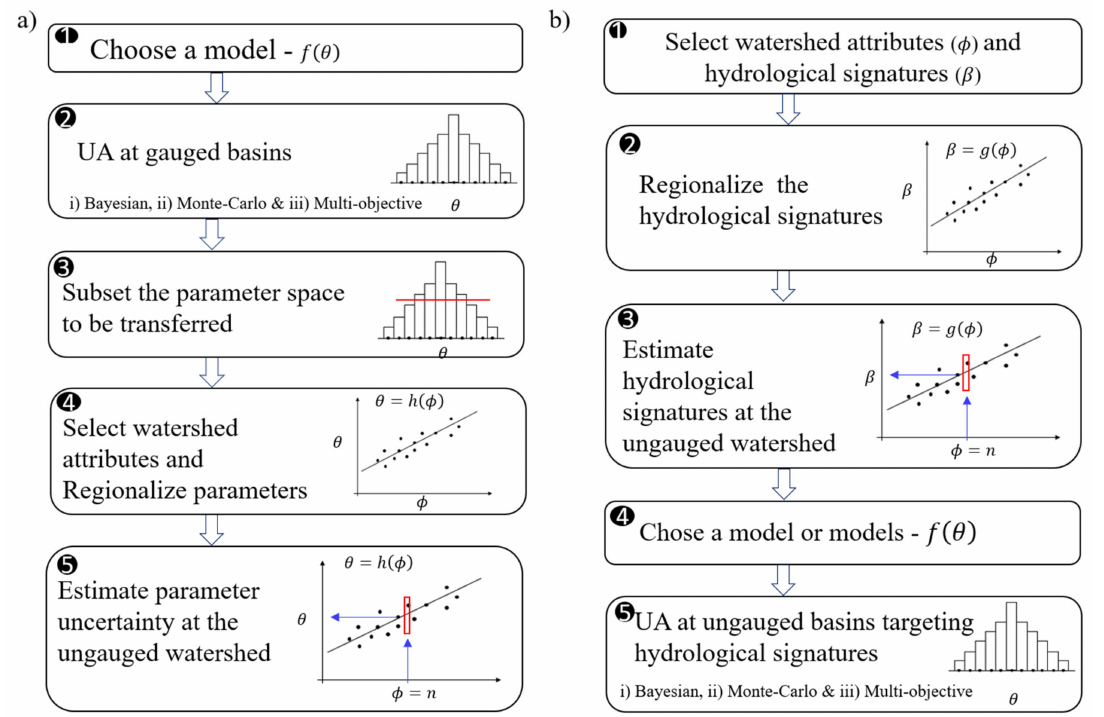
Figure 5. Stages of UA in ungauged basins: ( a ) model dependent and ( b ) model independent